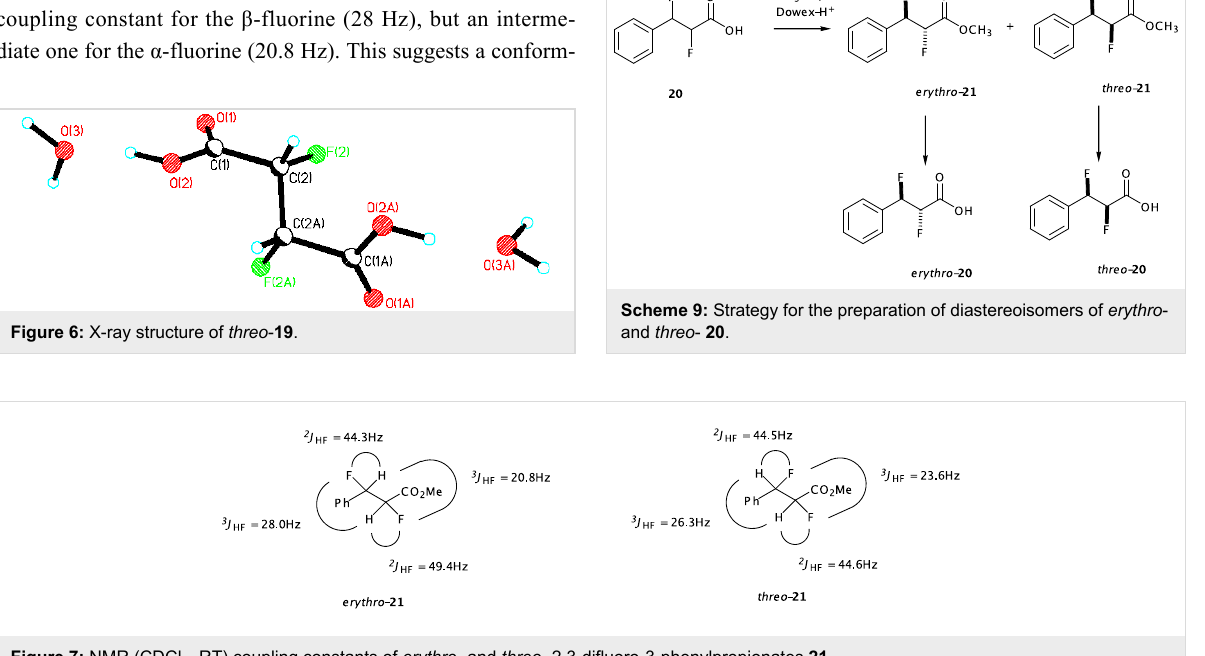
Figure 7: NMR (CDCl 3 , RT) coupling constants of erythro - and threo - 2,3-difluoro-3-phenylpropionates 21 .